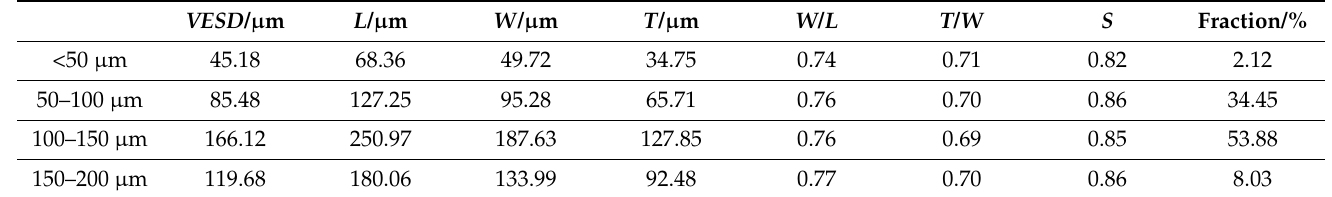
Table 2. Average values of size indexes and shape descriptors of desert sand particles with different sizes.